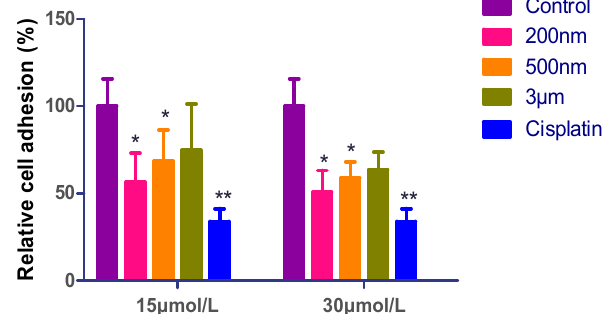
Figure 3. E ff ects of di ff erent sizes and concentrations of QE-NCs on the adhesion rate of A549 cells Figure 3. Effects of different sizes and concentrations of QE-NCs on the adhesion rate of A549 cells ( n ( n = 6). * p < 0.05, ** p < 0.01, compared with the blank control group. = 6). * p < 0.05, ** p < 0.01, compared with the blank control group. Table 3. The adhesion rate of QE-NCs of di ff erent particle sizes on A549 cells ( n = 6). Table 3. The adhesion rate of QE-NCs of different particle sizes on A549 cells ( n = 6). Concentrations